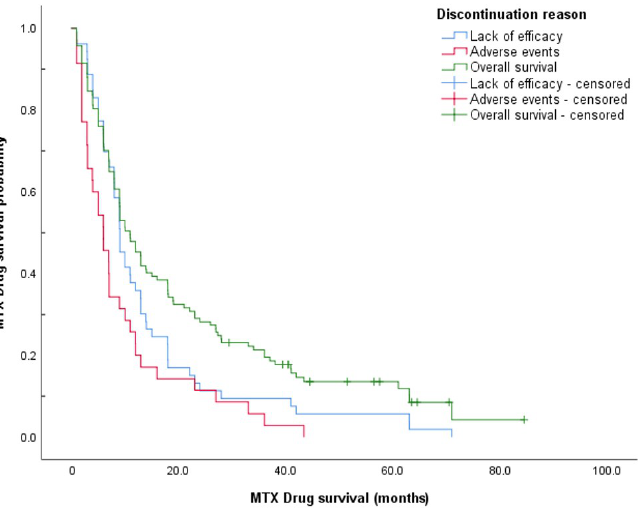
Figure 1. Methotrexate drug survival curves according to reason for discontinuation. Survival curves of the two discontinuation groups (i.e., lack of efficacy vs. AEs) were compared using log-rank tests, with a significant difference seen ( p = 0.049). To gain further insight into this finding, the groups were stratified by sex. This difference in drug survival according to the reason for discontinuation appears to be solely driven by the significant difference in survival curves for females (log-rank test, p = 0.002), as this was lost for males ( p > 0.05). Median drug survival for women discontinuing methotrexate treatment for